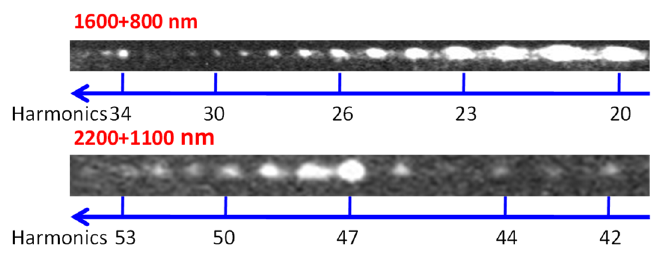
Figure 4. Raw images of harmonic spectra generated in tin plasma in the case of application of Laser2. Upper panel: OTC (1600 + 800 nm) of LIP when H34 was notably stronger than the adjacent harmonics. Bottom panel: OTC (2200 + 1100 nm) of LIP when H47 dominated over other harmonics.